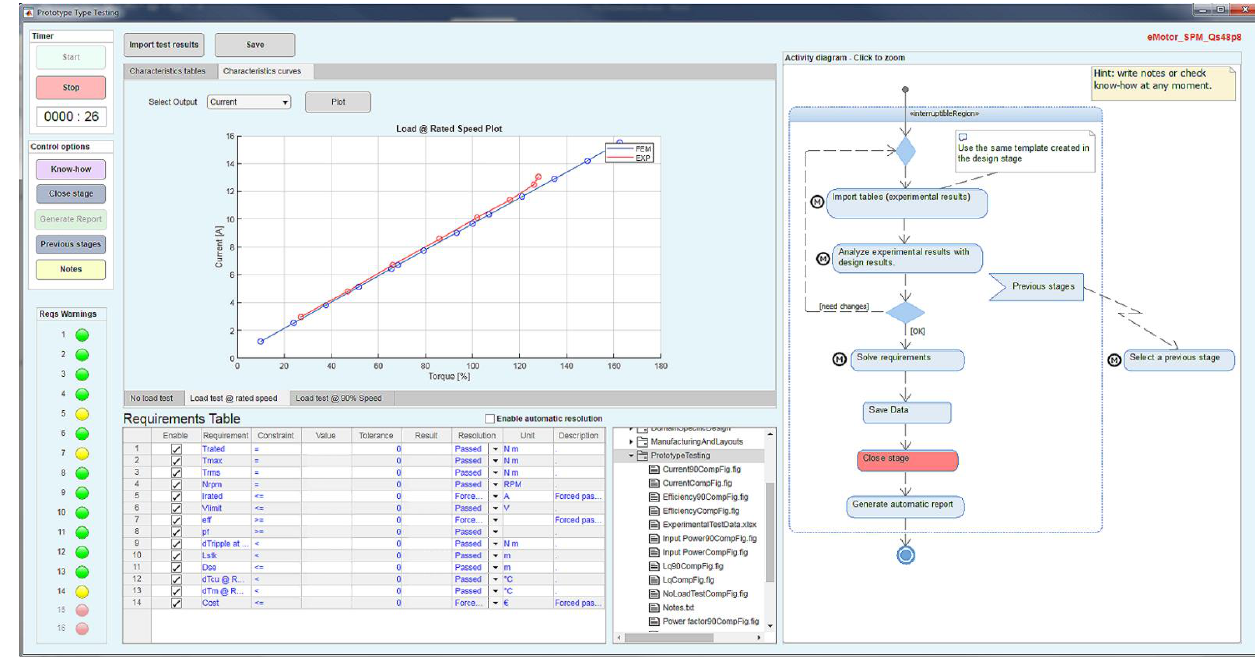
Figure 18. User interface for the prototype testing stage.